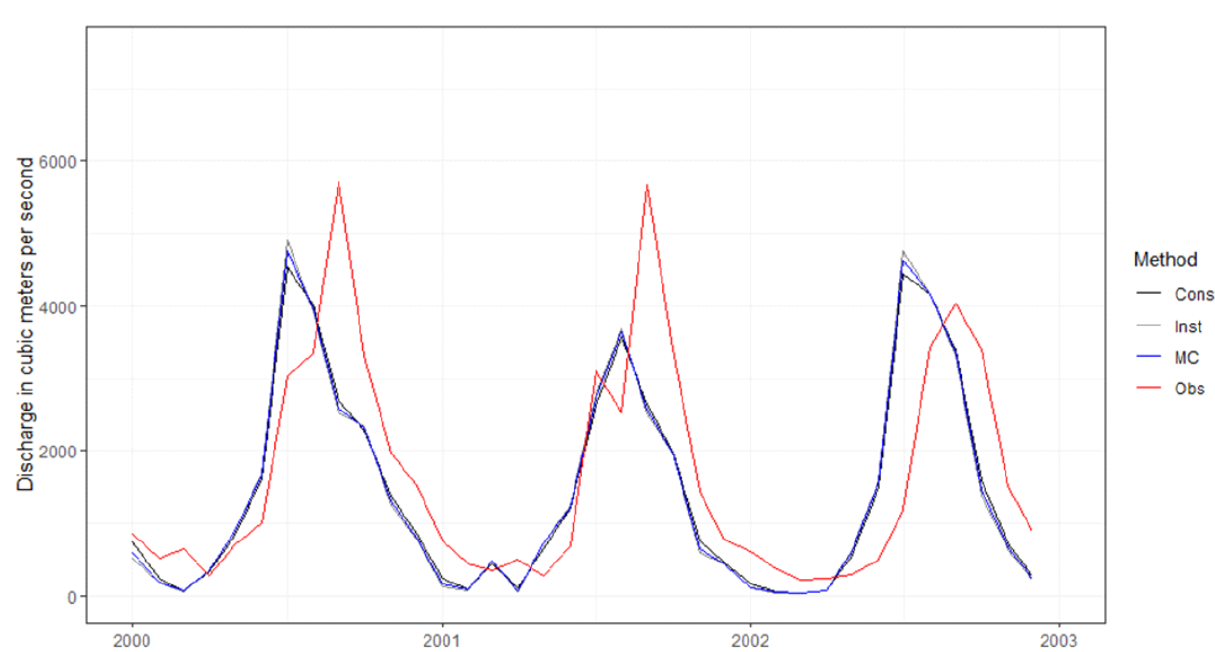
Figure B2. Predicted monthly LPJmL-GSWP3 flow of the three routing methods at Sekong Downstream Station. Figure showing a sample of years 2000–2002. MC stands for Muskingum–Cunge algorithm, Const. for constant velocity routing, Inst. for instantaneous routing, and Obs. for